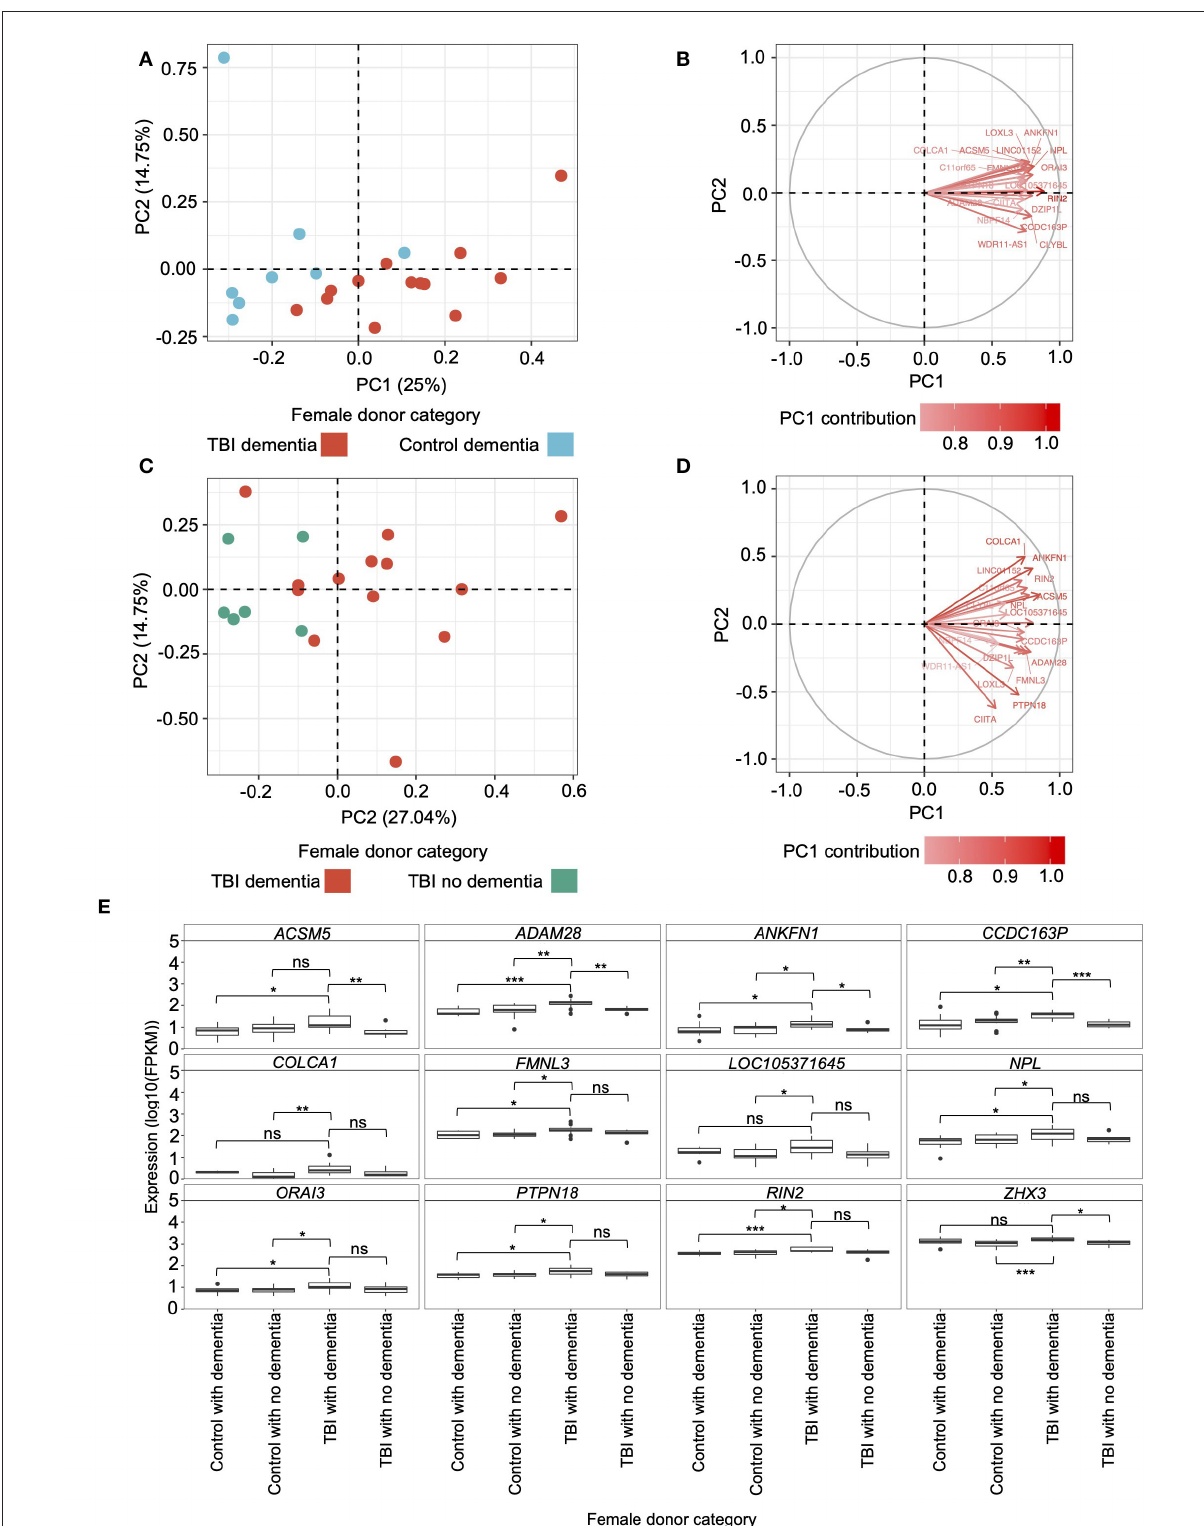
FIGURE4 Principal component analysis (PCA) and gene-protein correlations of candidate modules from the female hippocampus. (A) PCA using fragments per kilobase of transcript per million mapped reads (FPKM) of the genes assigned to candidate modules in the hippocampus of